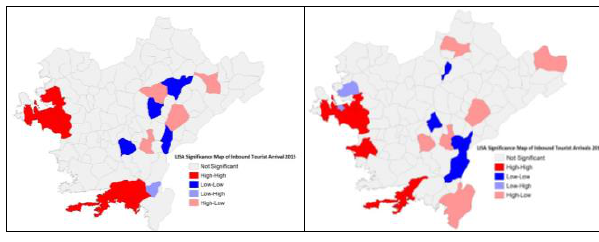
Figure 3. The Moran’s significance maps for inbound tourist arrivals (2015 and